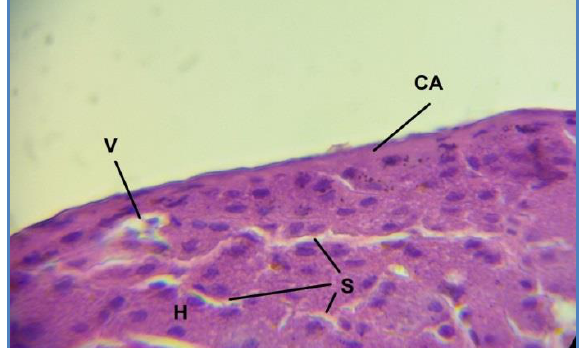
Figure, 9: Histological section of the liver in white-eared bulbul shows, the central vein (CV), hepatocyte plates (HP), sinusoids (S) Portal vein (PV) (H and E 40X).